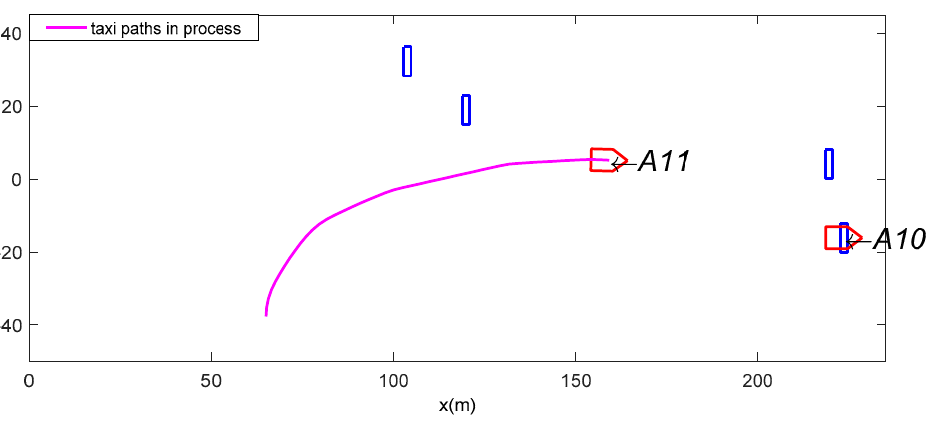
Figure 18. The state of aircraft when t = 130 s.